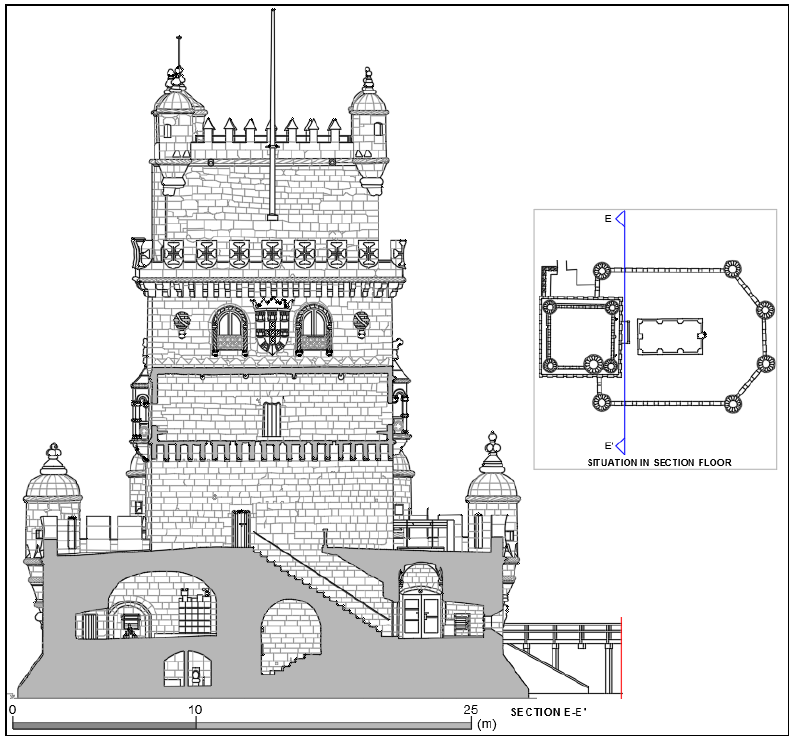
Figure 19. Elevation drawn from a vertical slice tangent to the Gothic tower south facade.